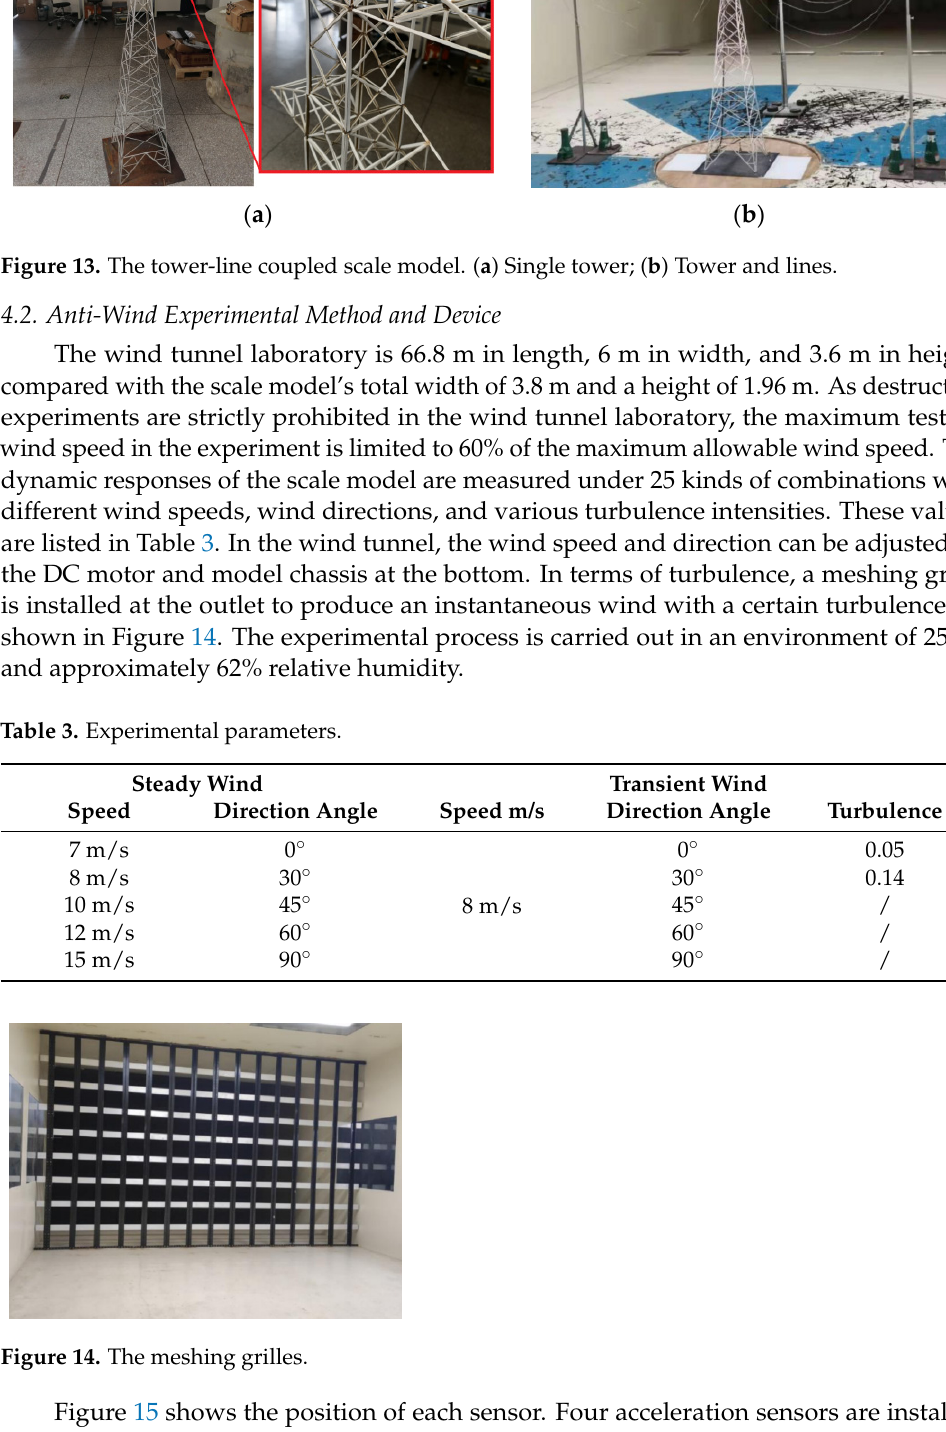
Figure 15. The installation of the five sensors. 4.3. Experimental Results and Analysis Figures 16 and 17 show the five sensors’ recording results in the steady wind and transient wind tests, respectively. ( a )